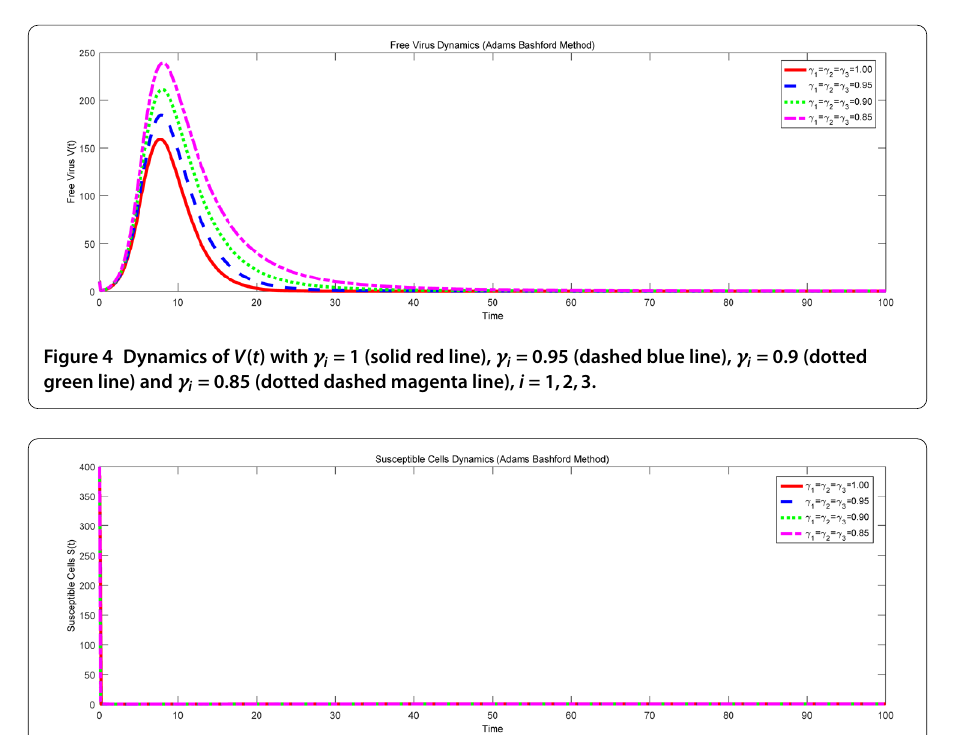
Figure 3 Dynamics of I ( t ) with γ i = 1 (solid red line), γ i = 0.95 (dashed blue line), γ i = 0.9 (dotted green line) and γ i = 0.85 (dotted dashed magenta line), i = 1,2,3.